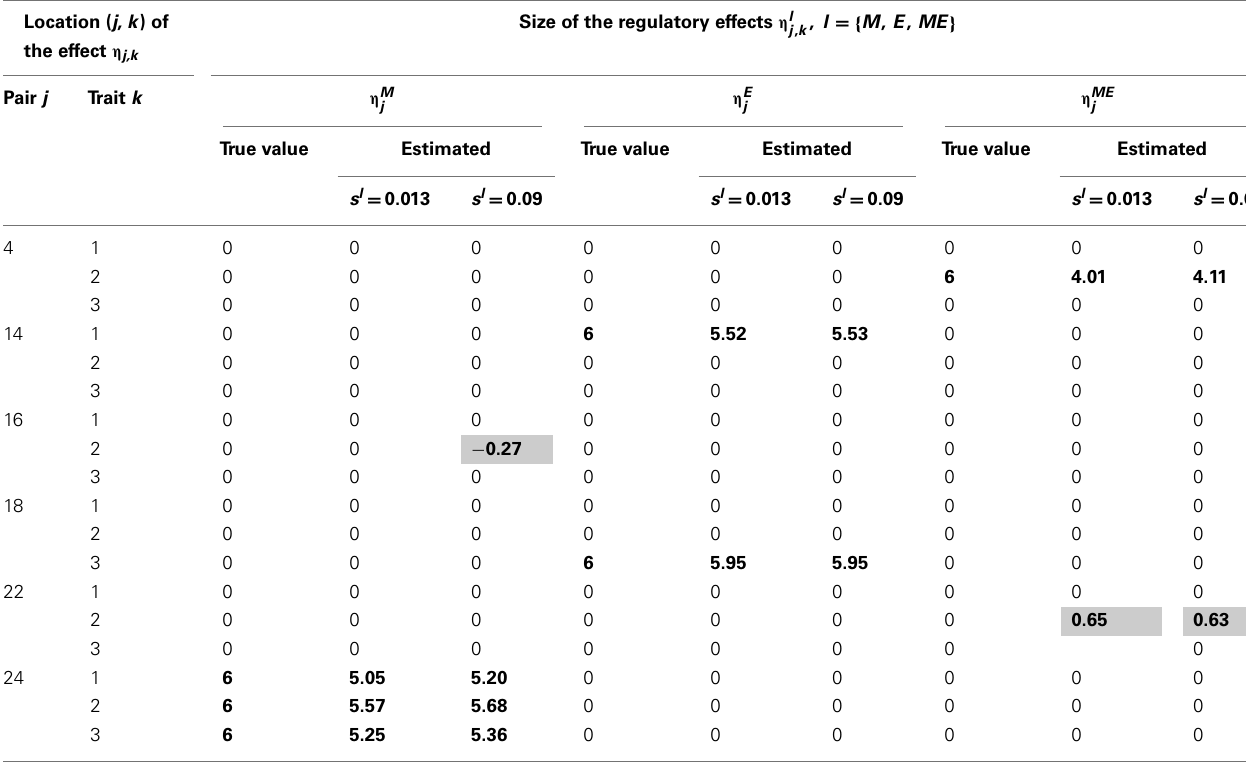
Table 2 |True and estimated (posterior means) cQTL effects under the MD1 version of the HB multi-trait cQTL model with 10% markers and 10% expressions coded as missing and different values of Bernoulli parameter s l . Location ( j , k )